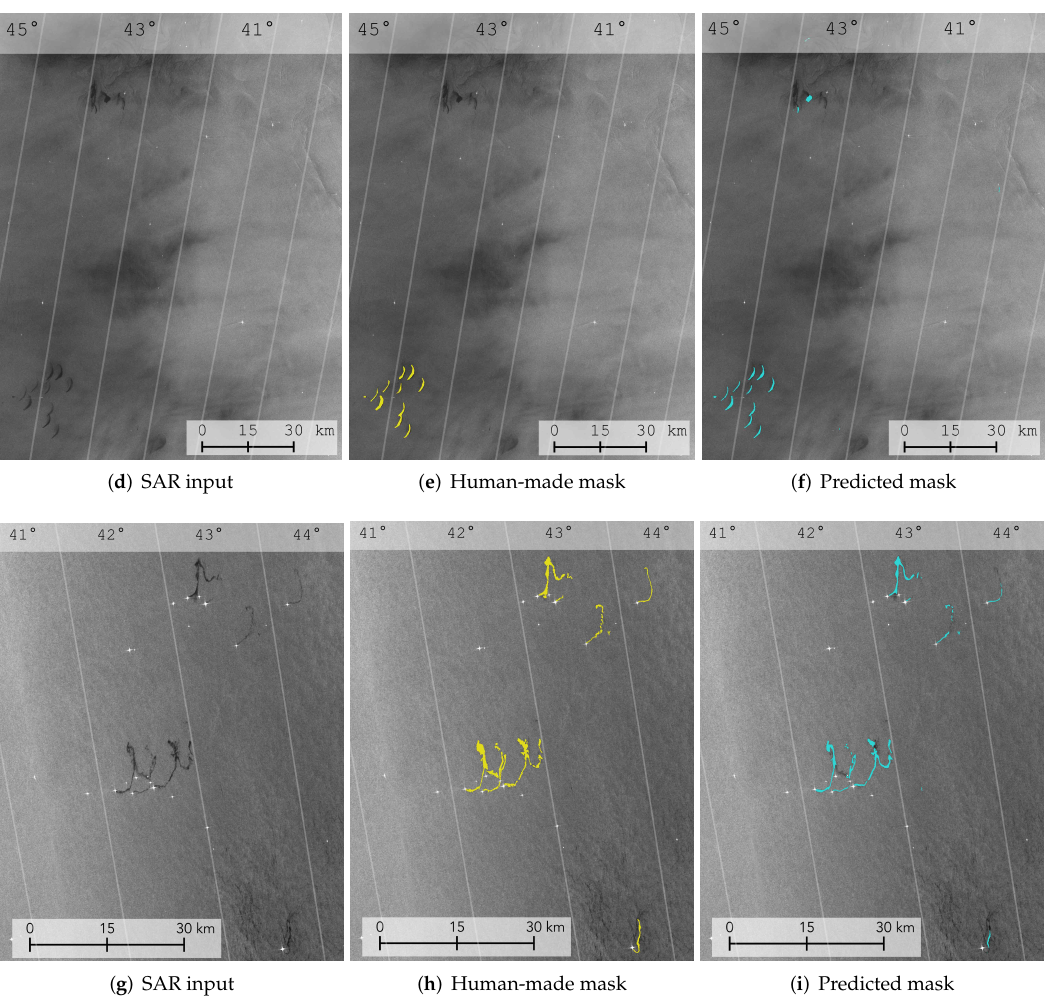
Figure 11. Results on the 3 Sentinel-1 products used for testing. The first column contains the original SAR images (VV-intensity); the second column contains the segmentation masks of oil spills that are manually drawn by human operators (yellow masks); the third column contains the segmentation masks of oil spills that are predicted by the OFCN (blue masks). Only small sections of the whole SAR products are shown in the figures. The number on the top of the images represent the incident